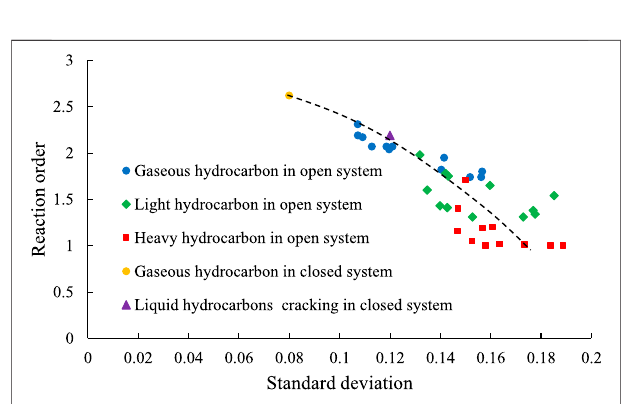
FIGURE 11 | Reaction order and standard deviation of different hydrocarbon generation